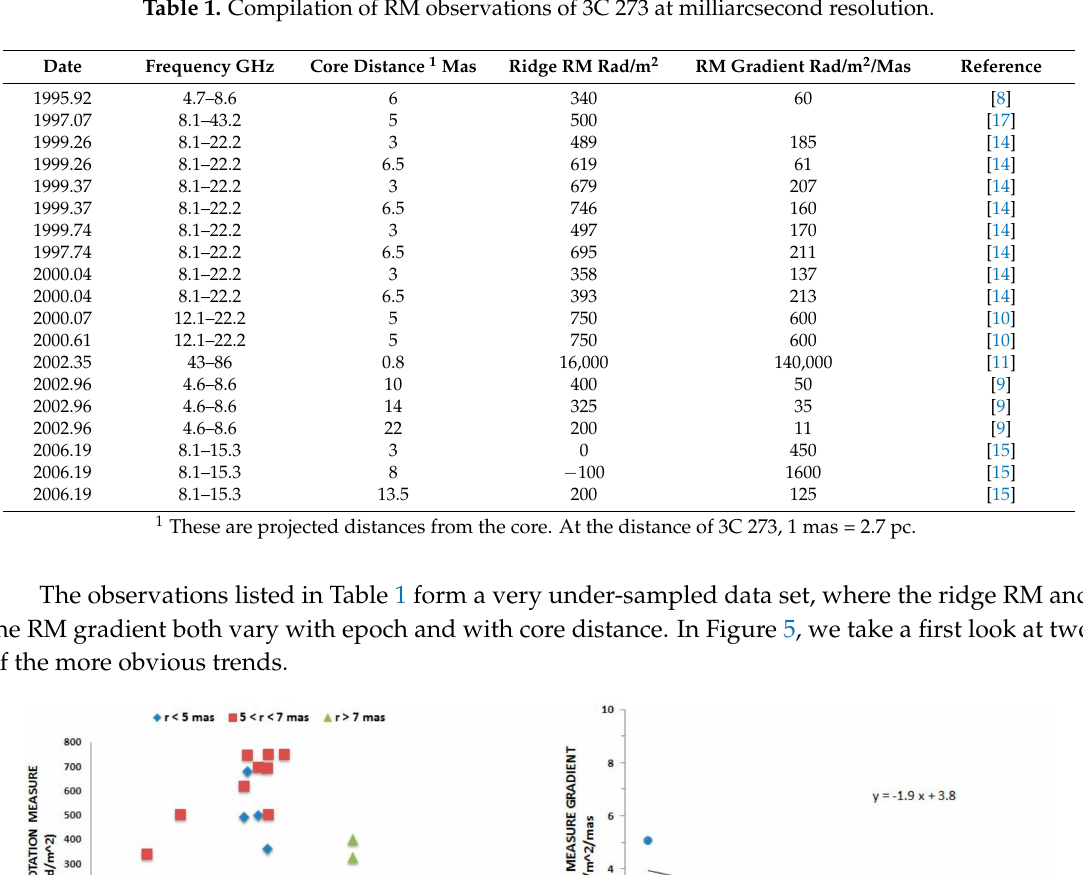
Table 1. Compilation of RM observations of 3C 273 at milliarcsecond resolution.